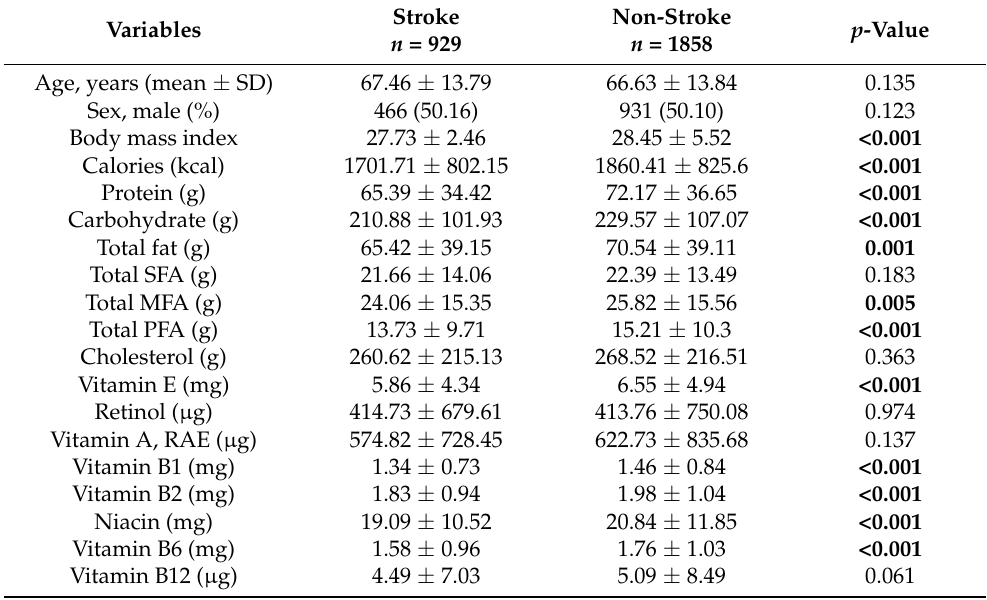
Table 1. Demographic and dietary consumption characteristics in participants with and without stroke.